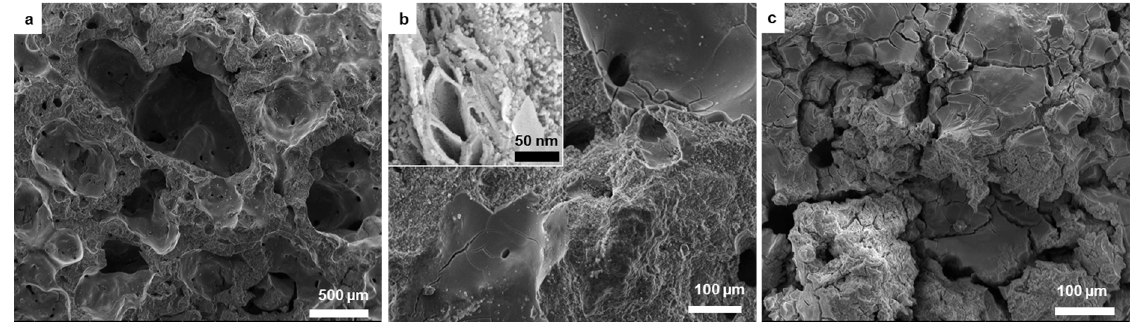
Figure 4. Microstructure of MKBM50 ( a , b ) and MKBM75 ( c ).